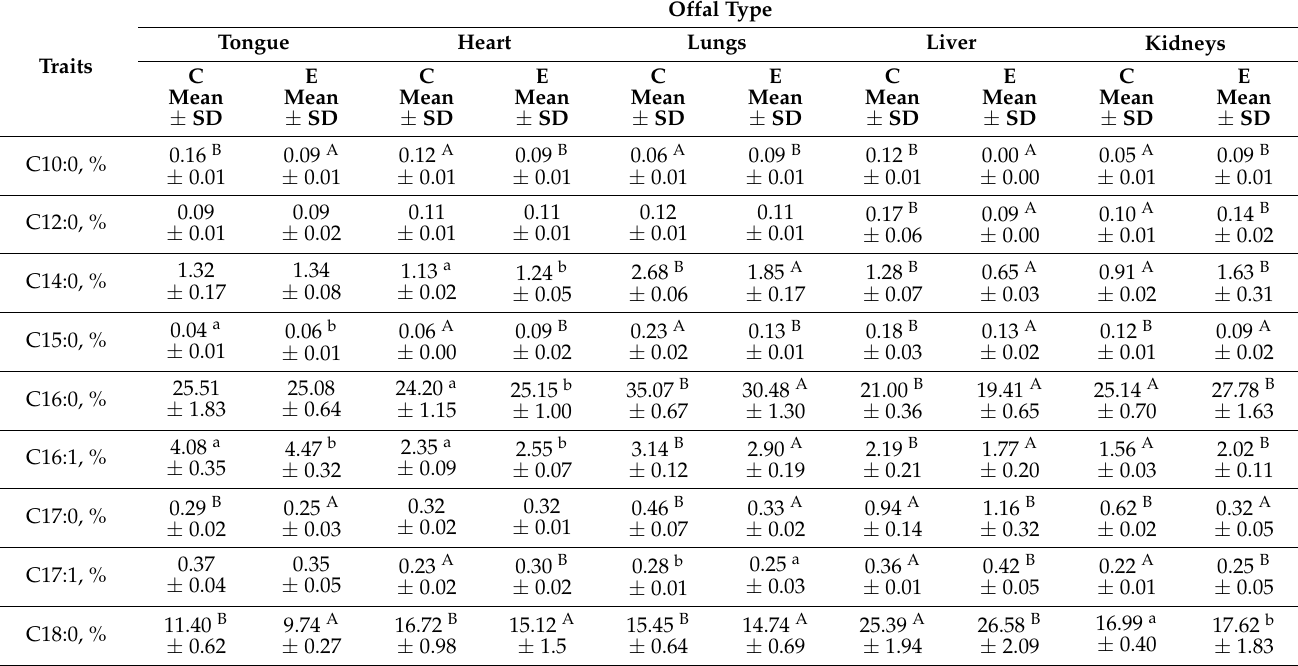
Table 6. Fatty acids content of the